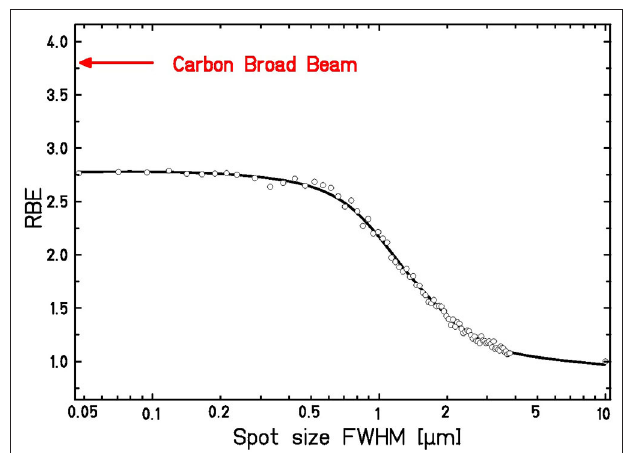
FIGURE 4 | Expected dependence of RBE for a hypothetic cell line on the spot size of focused high-energy, low-LET protons at a mean dose of 1.0Gy. For comparison, the RBE for broad beam carbon ion irradiation is shown. Calculations are based on the LEM input parameters: α Photon = 0.1 Gy − 1 , β Photon = 0.05 Gy − 2 , D t = 8Gy, E p = 19.95 MeV, LET p = 2.67 keV/ µ m, E C = 4.05 MeV/u, LET C = 338 keV/ µ m.